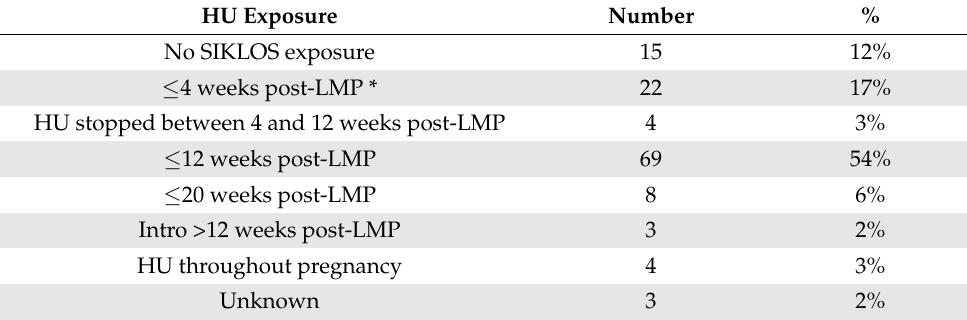
Table 3. Exposure periods to HU during pregnancies (* LMP: Last menstrual